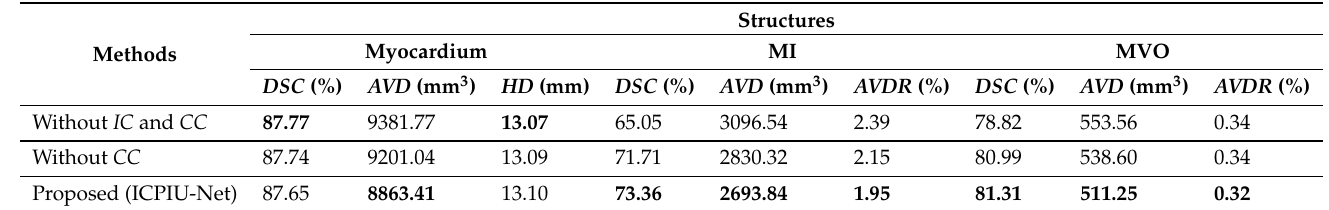
Table 5. Performance analysis and comparison between our proposed ICPIU-NET network without and with using IC and CC modules. Best values are marked in bold